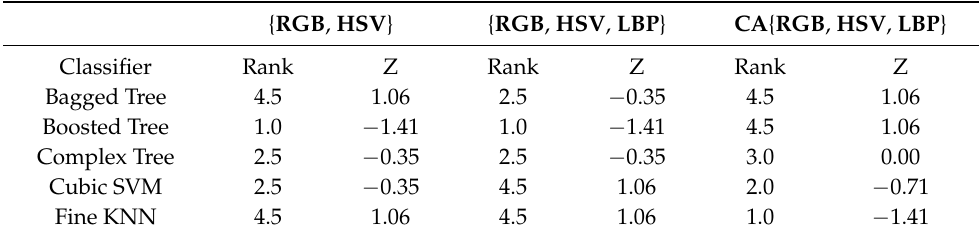
Table 9. Ranks obtained using the Kruskal-Wallis Test based on the mean accuracy and the perfor- mance deviating from the mean of one classifier to the mean of other classifiers using hybrid features. { RGB , HSV } { RGB , HSV , LBP }